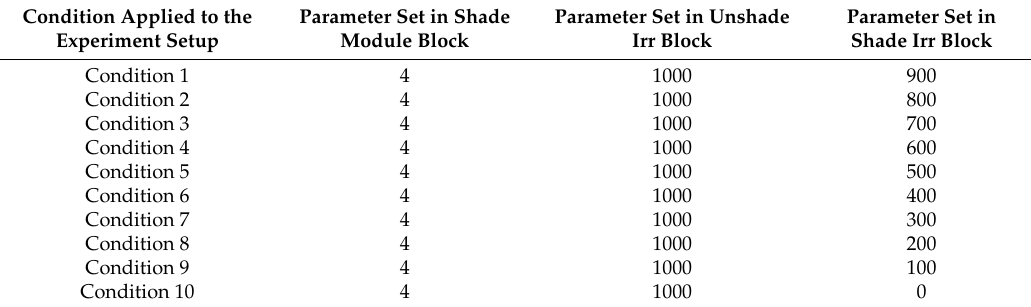
Table 2. Parameters set in the model shown in Figure 7 to conduct the experiment for the 4 modules shaded setup.